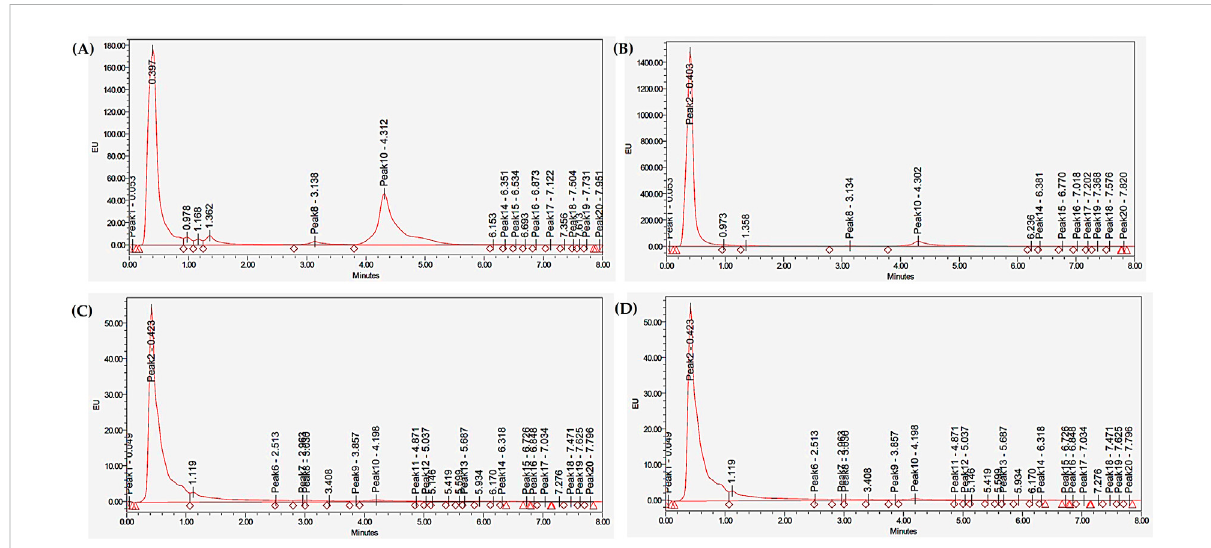
FIGURE 5 UPLCchromatogramsofAFB 1 fromthe invitro gastrointestinalpoultrymodel: (A) chitosan, (B) chitosan-soluble, (C) chitosan-insoluble,and (D) montmorillonite clay.